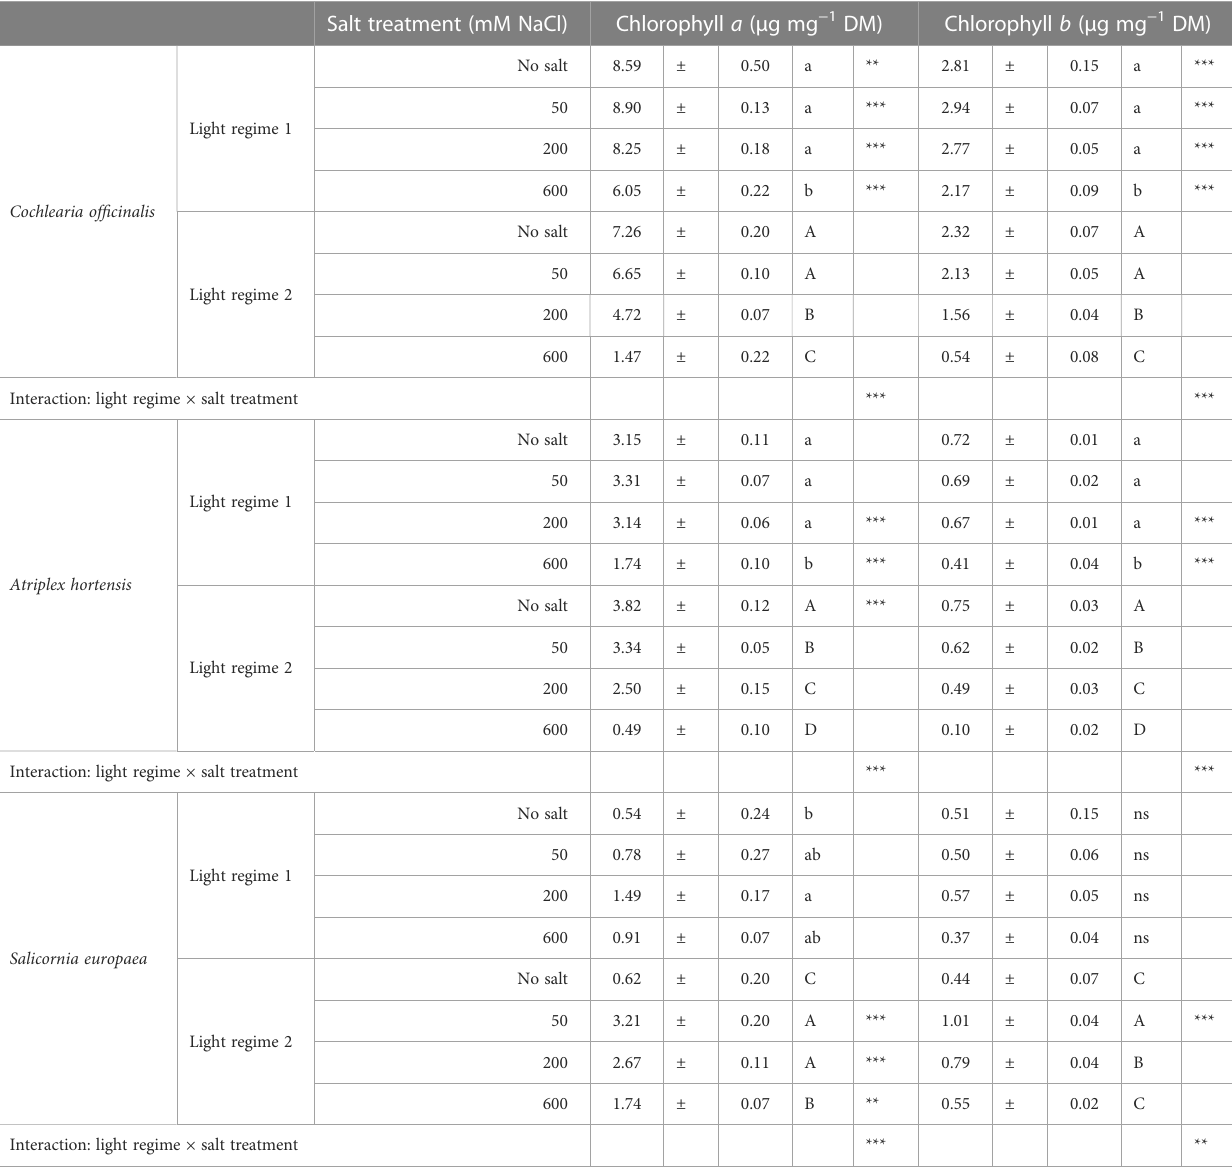
Small letters indicate signi fi cant differencesbetween salt treatments in light regime1 (LR1, greenhouse) in alphabetical order from highest tolowest; capitalletters indicate signi fi cant differences between salt treatments in light regime 2 (LR2, indoor farming) in alphabetical order from highest to lowest; asterisks indicate signi fi cant differences between LR1 and LR2 in between one salt treatment; interaction shows signi fi cantly different interactions between salt treatments and light regimes tested by two-way ANOVA, followed by post-hoc Bonferroni test (p ≤ 0.05) (** ≤ 0.01, *** ≤ 0.001); n = 8 pools of three individual plants each from two independent experiments. ns, not signi fi